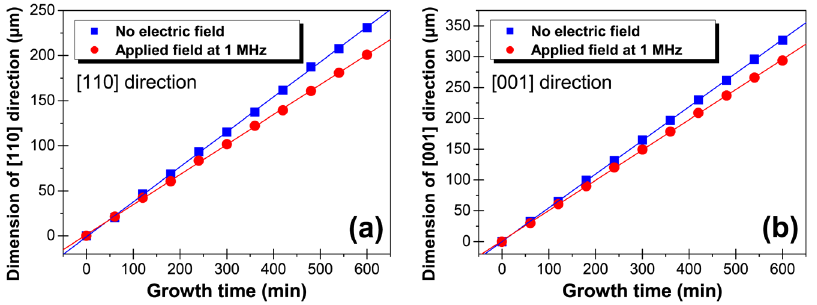
Figure 2. Crystal dimensions along ( a ) [110] and ( b ) [001] directions as function of growth time with and without external electric field, for growth temperature of 18 ◦